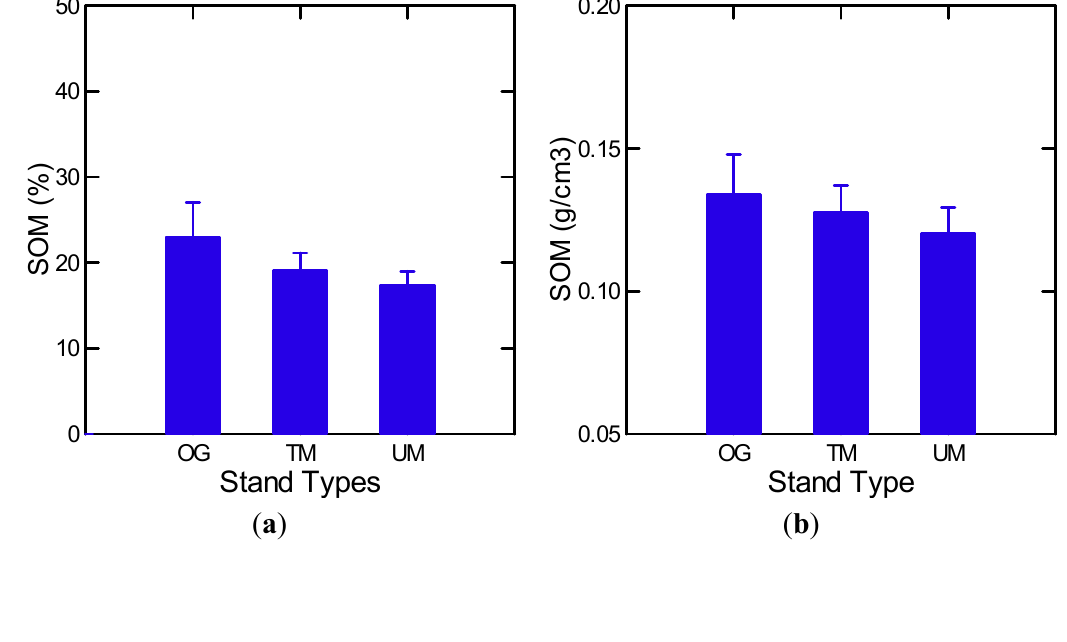
Figure 1. ( a ) Percent soil organic matter in top 10 cm of mineral soil, by stand type; ( b ) Soil organic matter content in top 10 cm of mineral soil, by stand type. Bars = standard